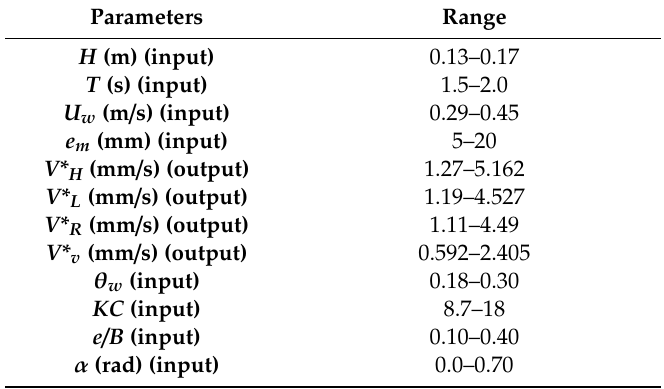
Table 1. Ranges of input–output parameters for the scour rate